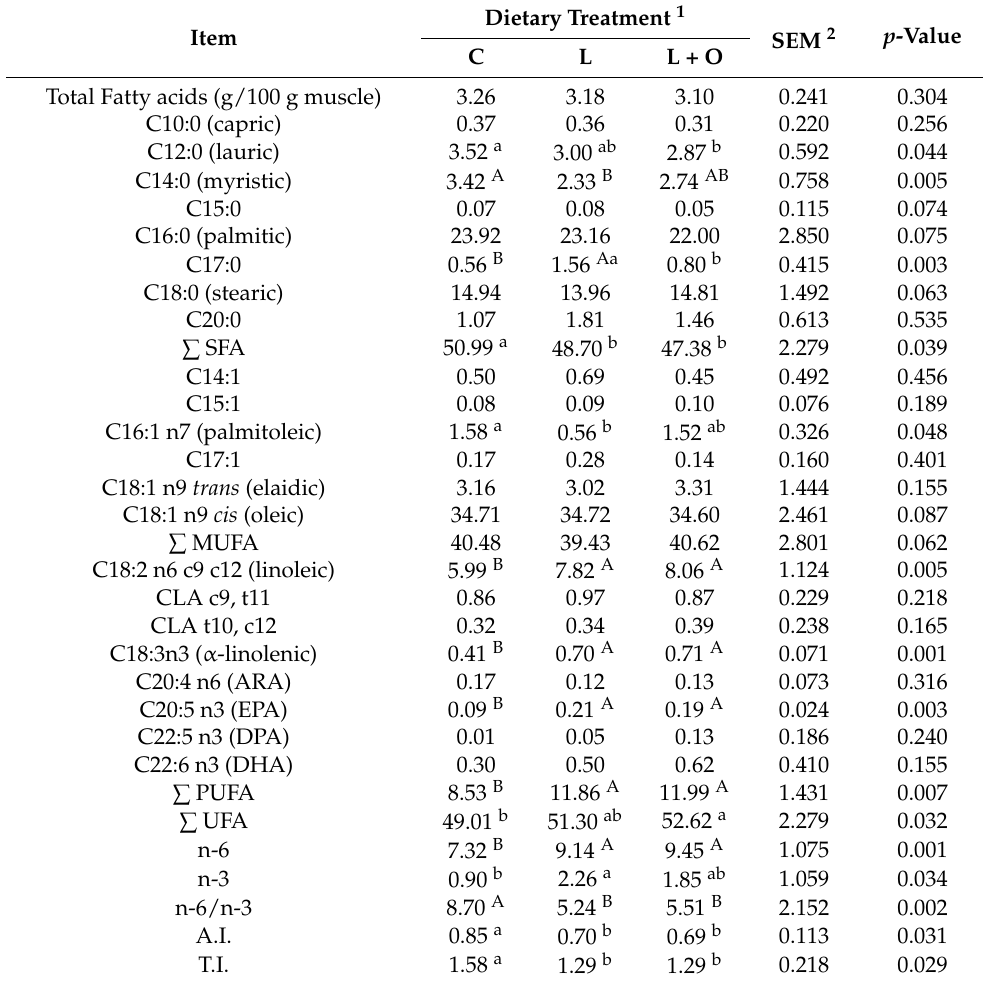
Table 9. Fatty acid composition (% total FA methyl esters) of lamb meat from Longissimus lumborum muscle *. Dietary Treatment 1 Item SEM 2 p -Value C L L + O Total Fatty acids (g/100 g